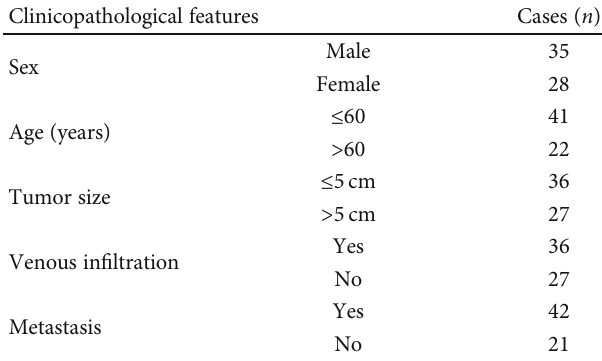
Table 1: The clinical feature of liver cancer patients. Clinicopathological